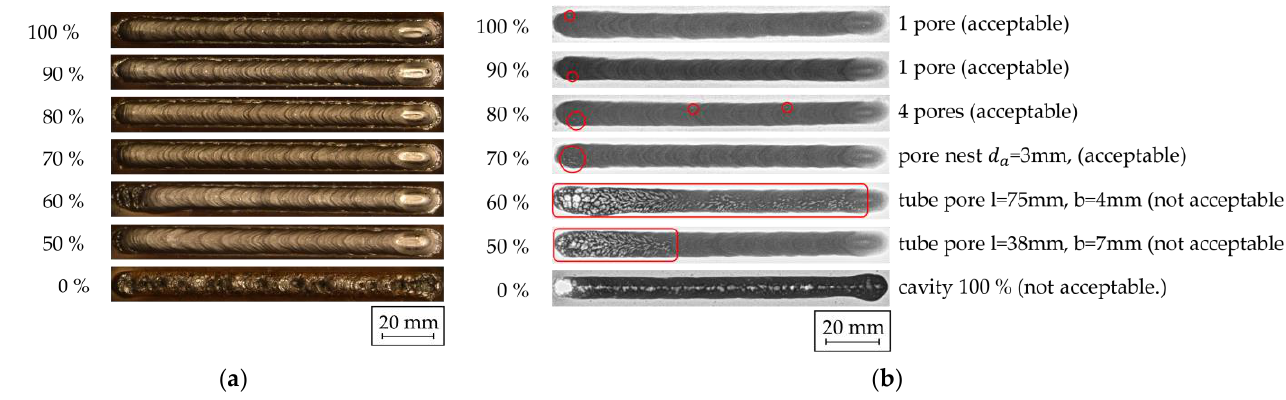
Figure 10. Top view of the welded beads with different shielding gas flow rates: ( a ) photo taken right after welding the bead; ( b ) radiographs of the welded beads with weld irregularities (marked in red) and their dimensions.